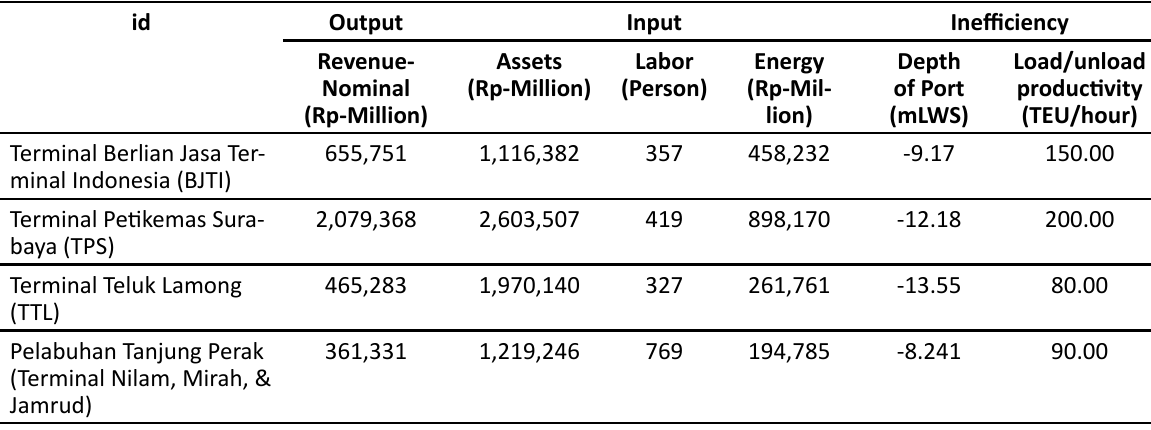
Table 1: Average Output, Input, and Inefficiency Variables